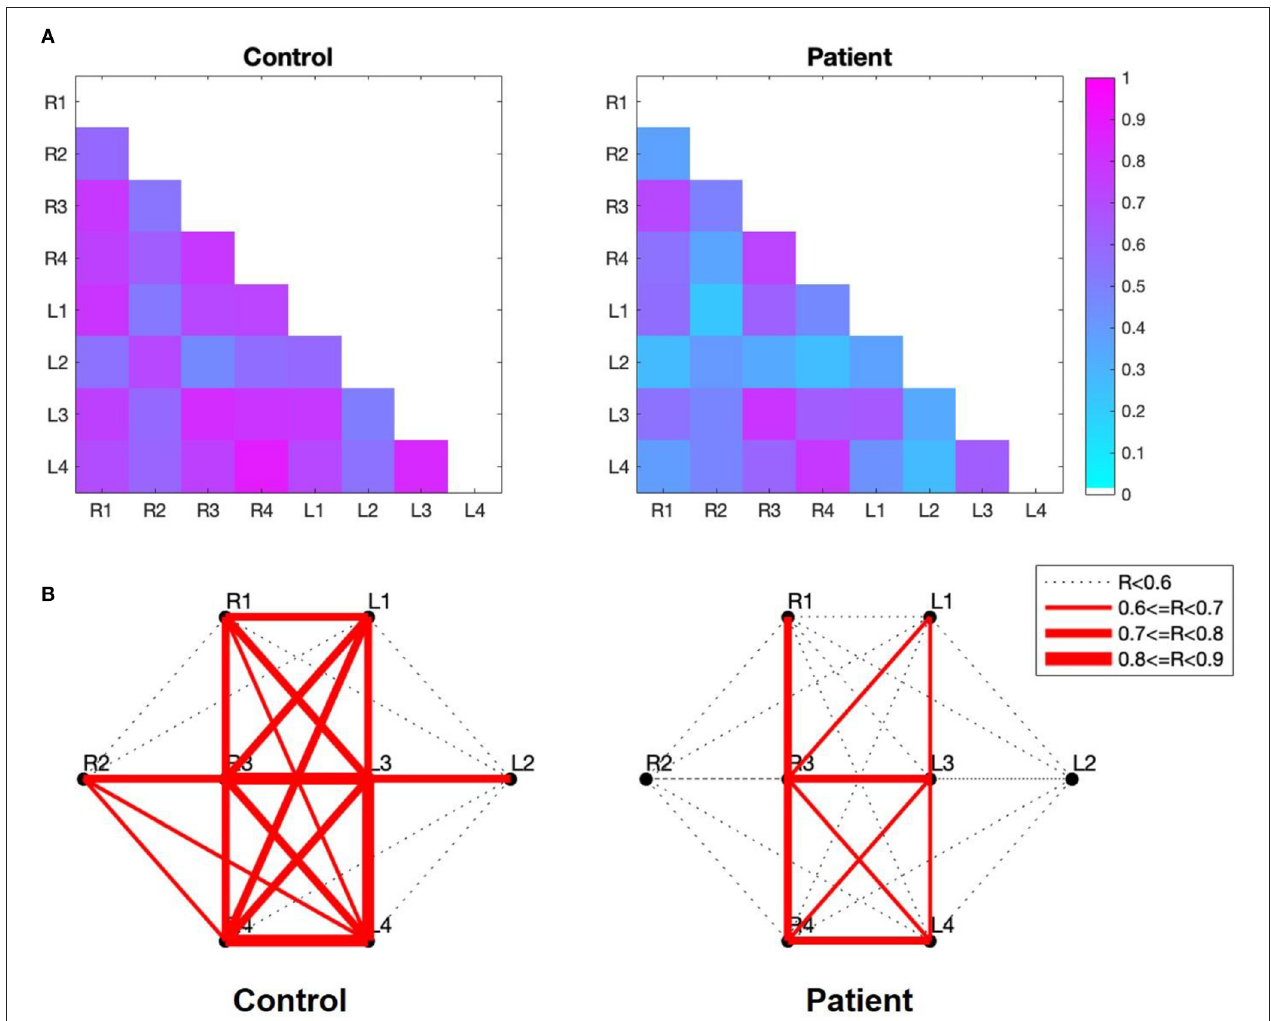
FIGURE 4 | (A) Correlation maps of the verbal fluency task for the two groups. The image shows the lower diagonal of the cross-correlation matrix. The rows and columns of the matrix represent the subgroup, while the cells of the matrix contain the color-coded correlation coefficient of the corresponding pair. The blue cells indicate a lower between-subgroup correlation, while higher between-subgroup correlations are indicated in magenta. (B) Subregion-based functional connectivity The line width indicates the strength of the correlation, as determined by the correlation coefficient (R) between each pair of